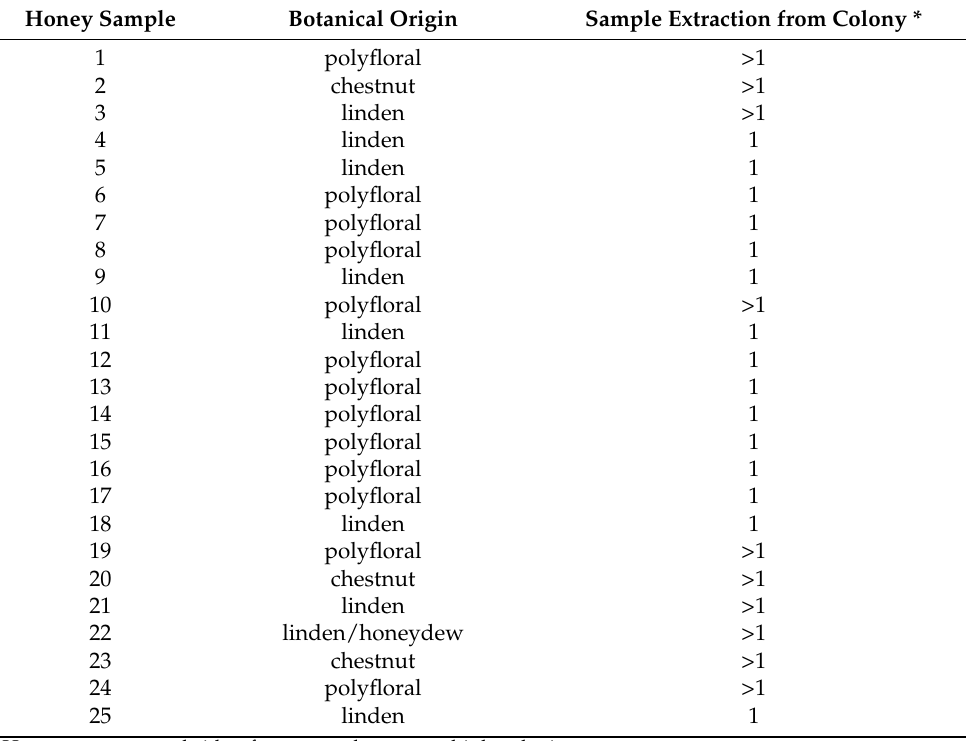
Figure 8. Honey sampling locations in Styria (Austria). Honey samples ( n = 25) were collected in the year 2020. Red color–honey samples; green color–honey samples and paired bee-processed syrups. Table 1. Austrian honey samples analyzed in study.